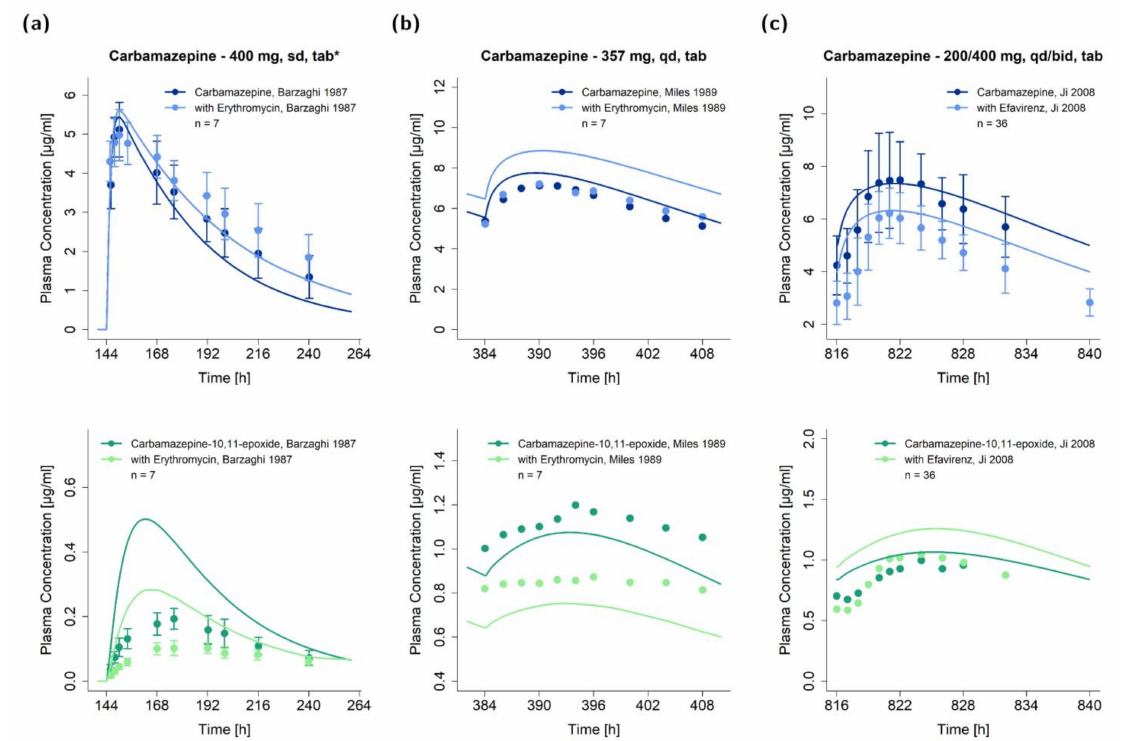
Figure 4. Victim drug plasma concentration − time profiles of the modeled drug–drug interactions with carbamazepine as victim drug (first row: carbamazepine, second row: metabolite carbamazepine-10,11-epoxide). Predictions of the victim drug plasma concentrations during the erythromycin − carbamazepine DDI ( a ) without and ( b ) with carbamazepine pretreatment [79,80] and ( c) the efavirenz − carbamazepine DDI [8] are shown in comparison to observed data. Observed data are shown as dots ± SD (if available); predictions are shown as solid lines. Details on the study protocols and model simulations of all investigated DDI studies are provided in the Supplementary Materials. md: multiple dose, n: number of individuals, sd: single dose, tab: tablet, tab*: tablet with concomitant food